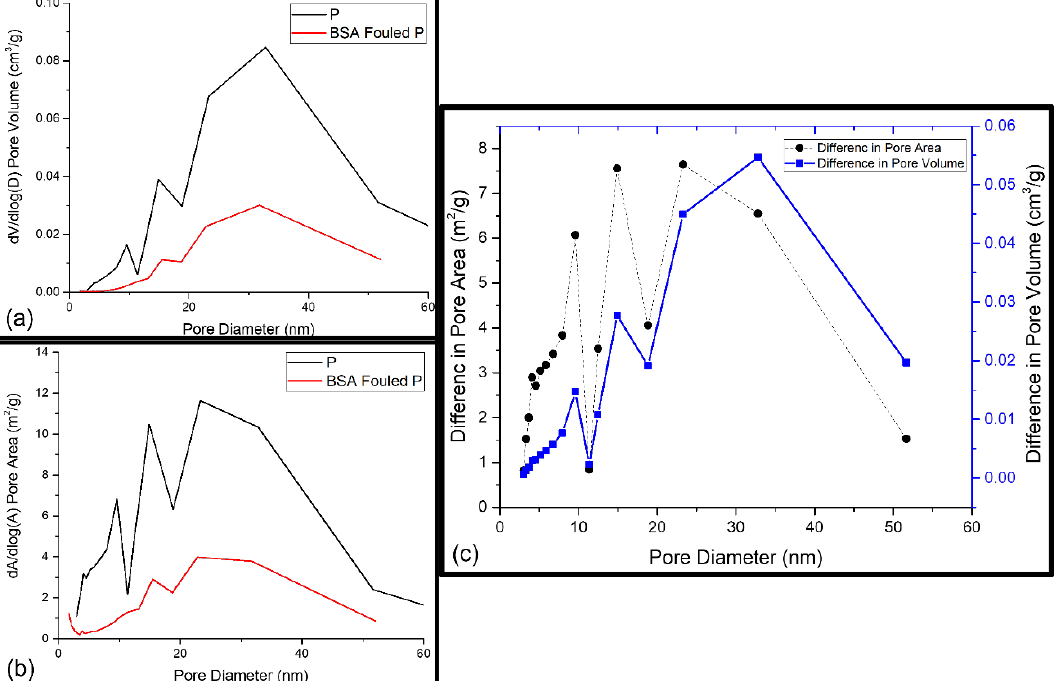
Figure 5. ( a ) BET pore area distribution of P and BSA-fouled P membranes; ( b ) BET pore volume distribution of P and BSA-fouled P membranes; ( c ) the difference between the pore area of P and BSA-fouled P and the difference between the pore volume of P and BSA-fouled P as a function of pore